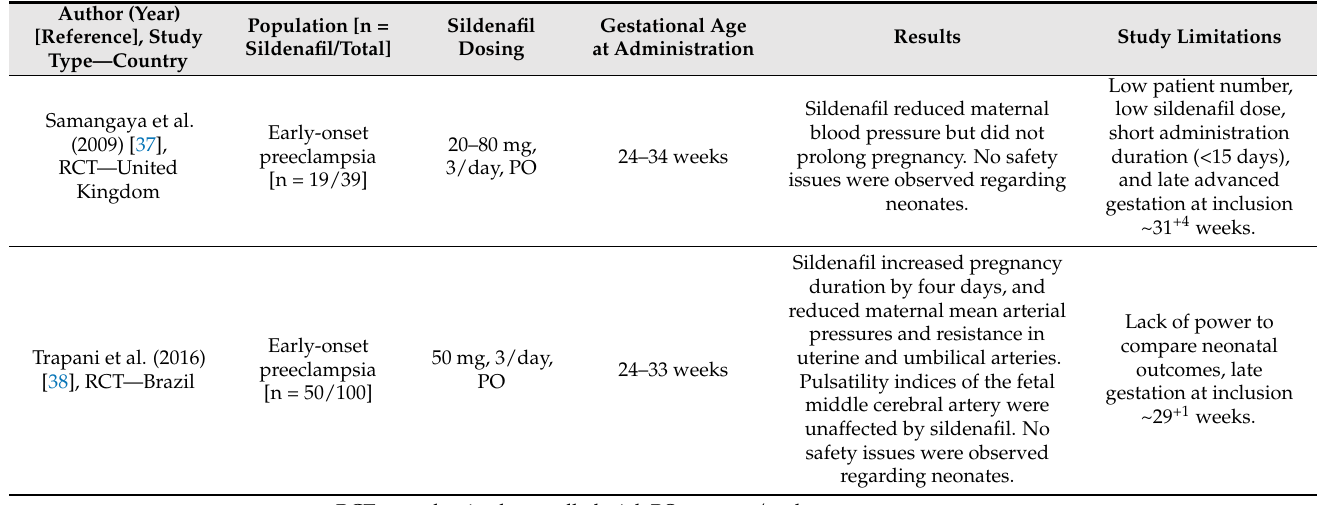
Table 1. RCT’s assessing sildenafil for